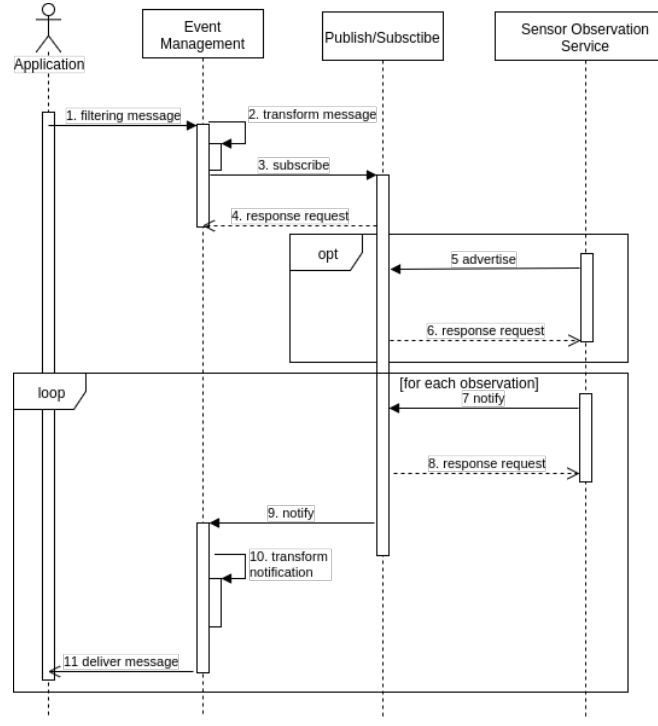
Figure 4. BM: Application, EM, Publish/Subscribe and